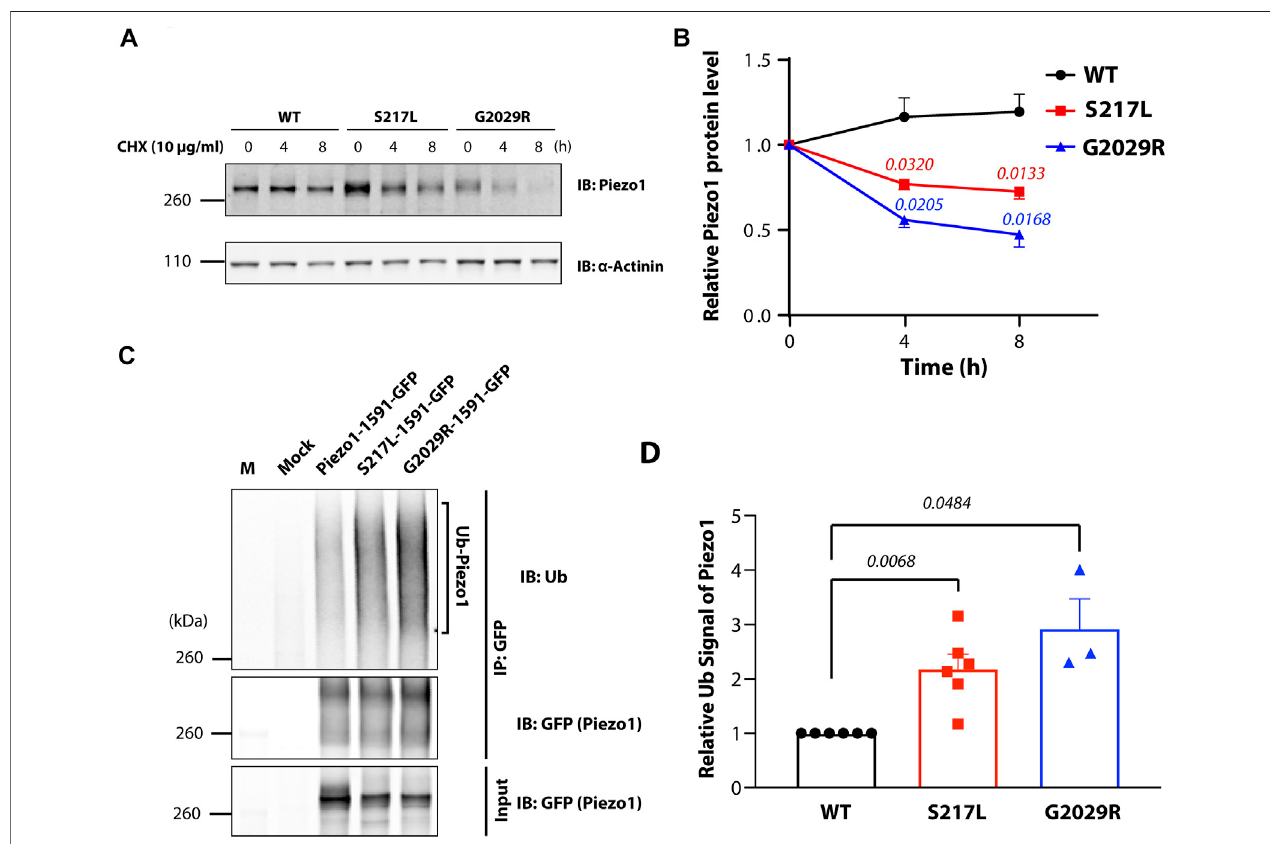
FIGURE 1 | Instability of Piezo1 loss-of-function mutants correlates with increased ubiquitination. (A) Piezo1 − / − HEK293T cells overexpressing wild-type (WT) or mutant Piezo1-GFP were treated with 10 μ g/ml cycloheximide (CHX) for 0, 4 or 8 h before being collected for western blotting. (B) Summary data of panel (A) showing Piezo1 protein levels normalized to α -Actinin. (* p (cid:2) 0.0320 and * p (cid:2) 0.0133 for S217L at 4 and 8 h; * p (cid:2) 0.0180 and * p (cid:2) 0.0168 for G2029R at 4 and 8 h) (C) WT or mutantPiezo1-GFP expressed in Piezo1 − / − HEK293T cells were immunoprecipitated using an anti-GFP antibody and the eluted fraction and input cell lysate were probed for Piezo1 levels. An immunoblot of the immunoprecipitated protein using a mono- and poly-ubiquitin (Ub) antibody is also shown (M (cid:2) marker). (D) Summary data of panel C showing the level of Piezo1 ubiquitination normalized to the level of immunoprecipitated Piezo1 protein ( n (cid:2) 4 for all experiments). One way ANOVA with Dunnett ’ s multiple comparison test was used for statistical